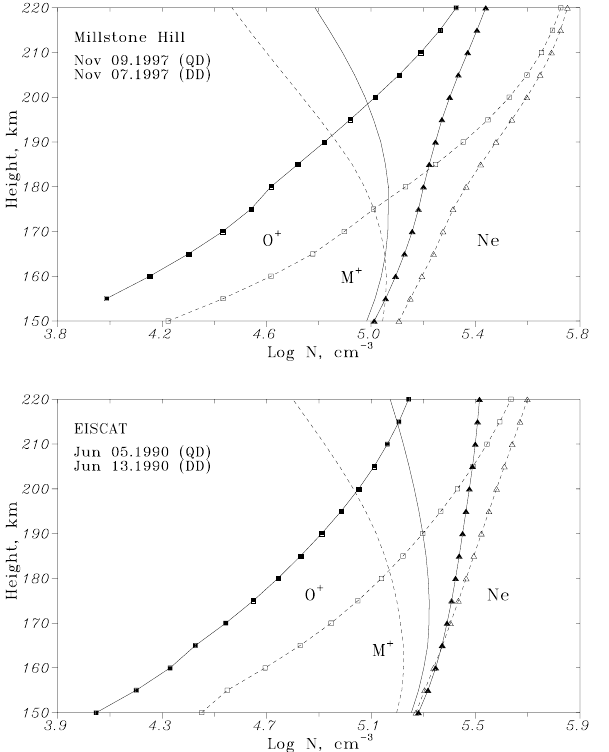
Fig. 4. Same as Fig. 3, but a simple analytical approach (Eq. 4) was used in the calculations. Note a close resemblance with Fig.